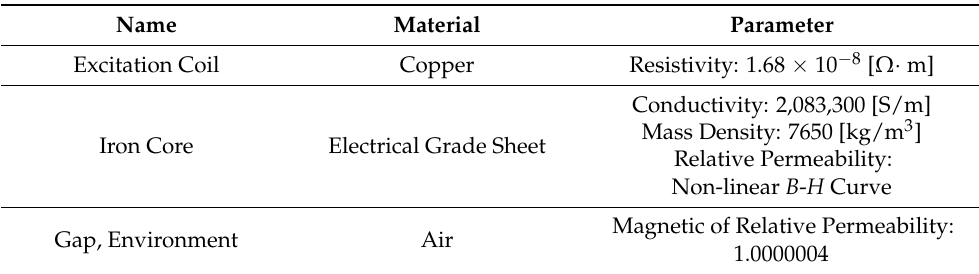
Figure 2. 2D simulation model diagram. Table 2. Materials of the simulation model. Table 2. Materials of the simulation model.